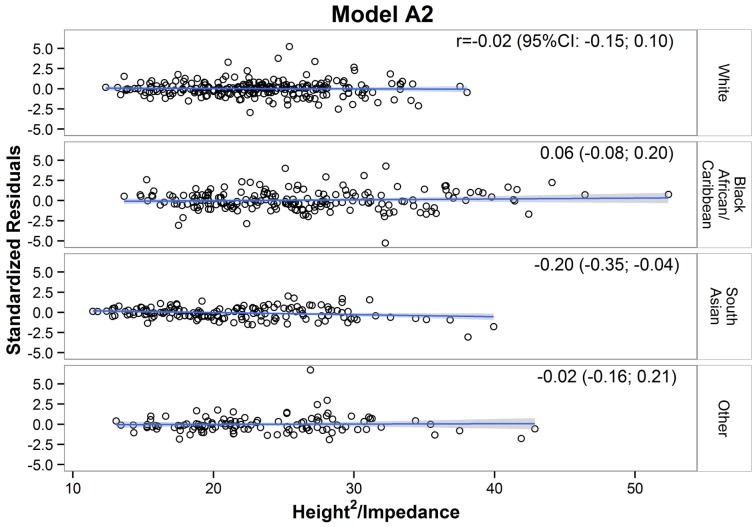
Residuals distribution for each ethnic group for model A2.Residuals from model A2 were regressed, for each ethnic group, on height2/impedance as indicated by the bold regression line. The shaded area represents a 95% confidence interval for the mean of residuals as a function of height2/impedance. Correlation coeffients (95% confidence interval) are also shown. No mean, and no slope, differed significantly from zero.